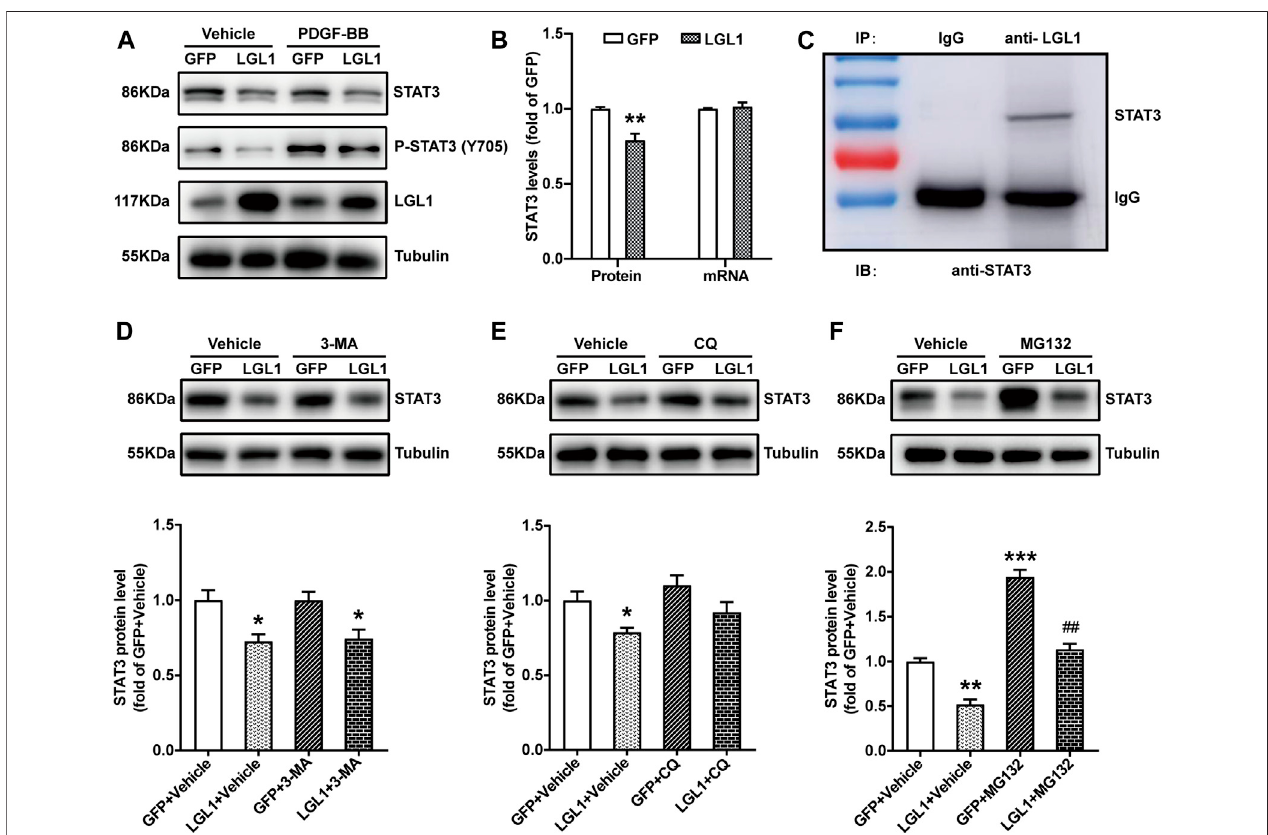
FIGURE 4 | LGL1 could bind with STAT3 and promote its degradation. (A) VSMCs were infected with adenovirus-expressing GFP or LGL1, then treated with PDGF-BB for 15 min. The protein levels of STAT3 and P-STAT3 (Y705) were measured by western blot analysis. (B) Statistical analysis of STAT3 protein and mRNA levels( n =4).** p < 0.01 vs GFP. (C) VSMClysateswereimmunoprecipitatedwithIgGoranti-LGL1antibody;STAT3protein levelwasdetected bywesternblotanalysis. (D – F) VSMCs were infected with adenovirus-expressing GFP or LGL1, then treated with 10 mM of the autophagic inhibitor 3-MA for 24 h (D) , 10 μ M of